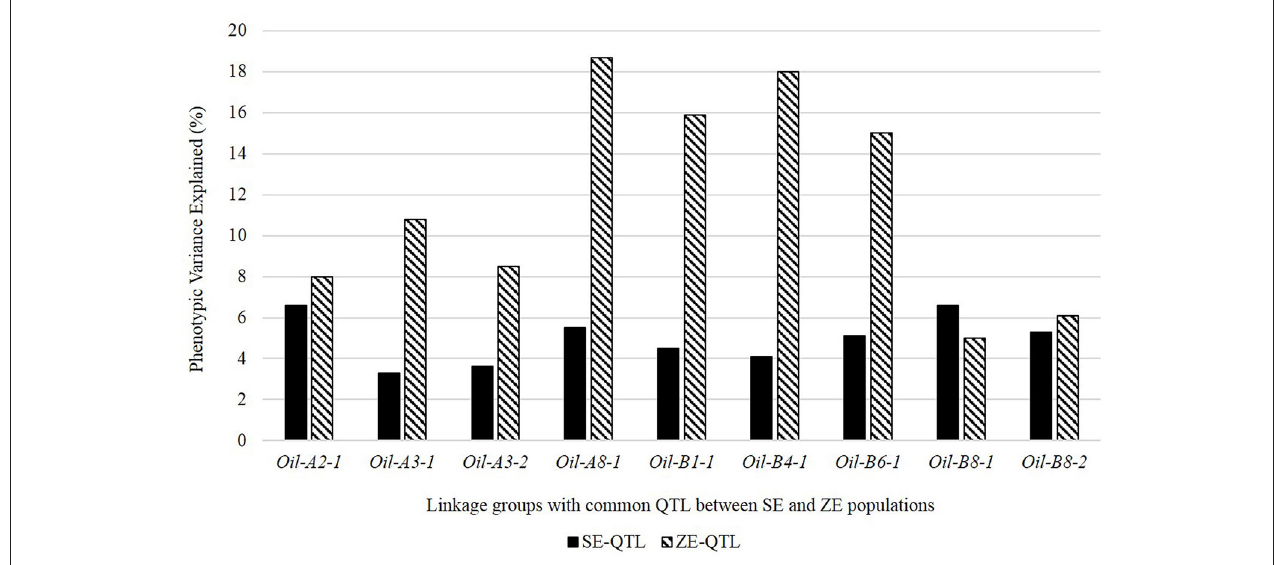
FIGURE 2 | Comparison of average phenotypic variance explained ( R 2 ) by “common” QTL identified between SE and ZE populations after QTL